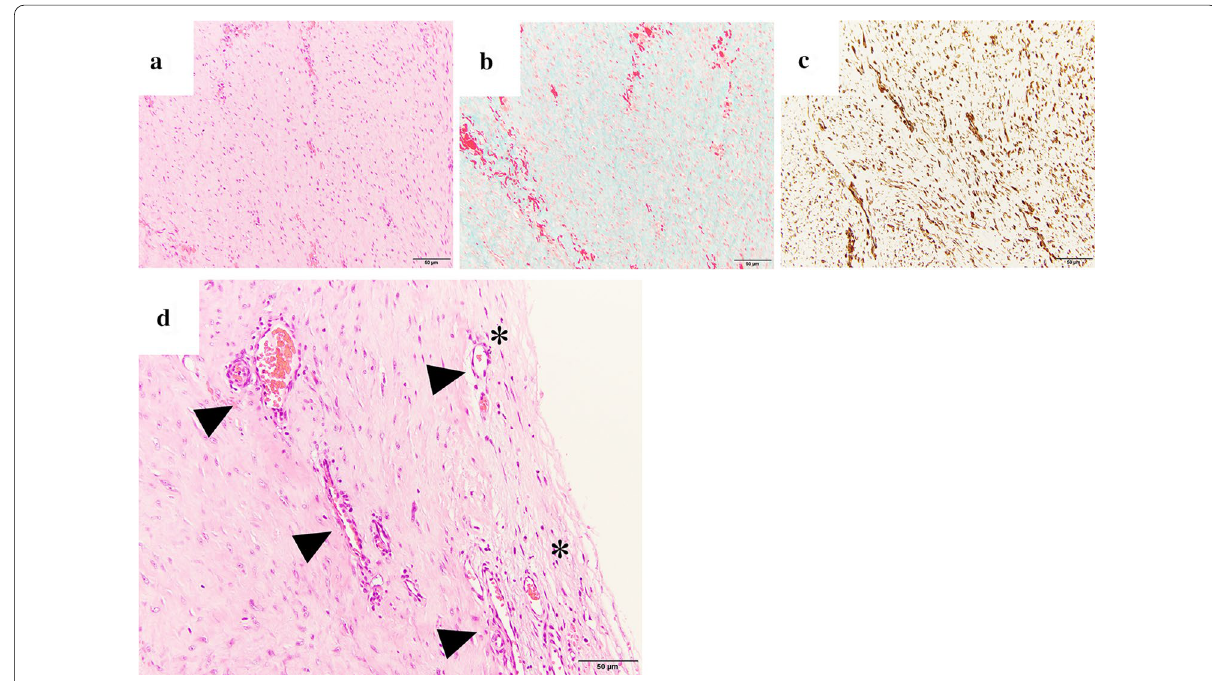
Fig. 4 Histopathology of the tumor. a , b Desmoplastic fibroblastoma cells are stellate or spindle-shaped cells undergoing infrequent mitotic activity, embedded in an abundant collagenous stroma ( a hematoxylin and eosin (H&E) staining, b elastica van Gieson staining). c Immunohistochemistry, demonstrating cells positively labeled for vimentin. d Examples of a capsule-like structure of fibrous tissue (*) and the abundant vascularity visible at the periphery of the tumor (arrowhead). (H&E